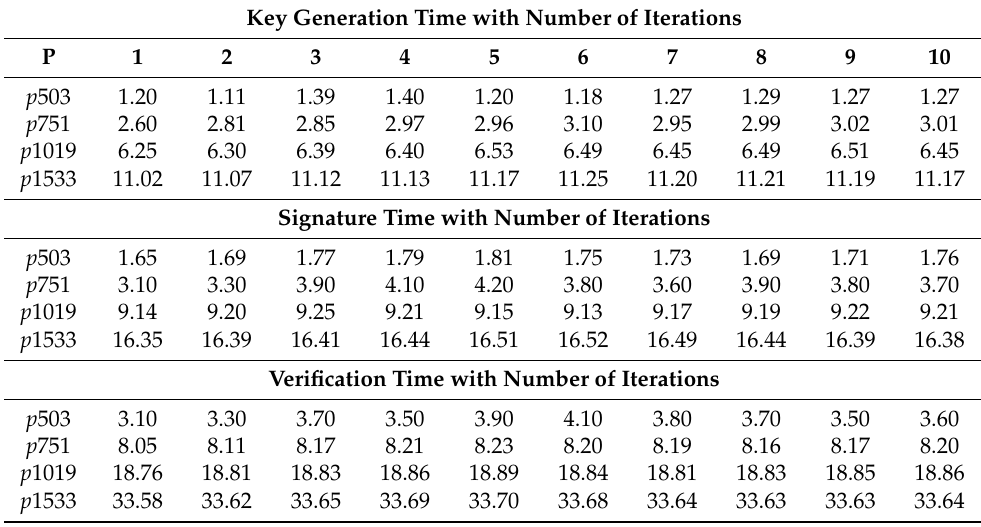
Figure 5. Various computation time of different phase vs. number of iterations with different p values. Table 4. Computation time of different phases for different prime values.